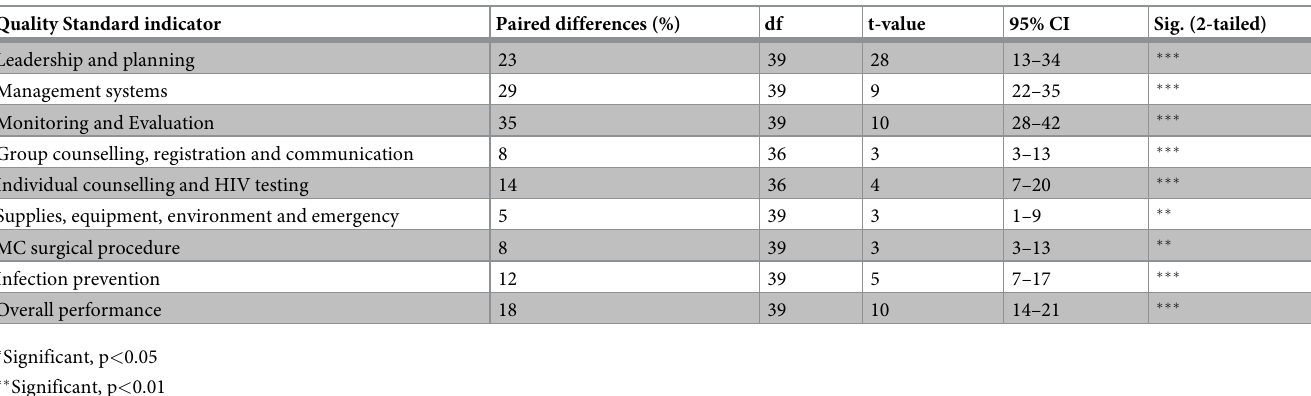
Table 2. Paired samples t-test for overall changes in quality of service mean scores after CQI support intervention by quality standard across provinces. Quality Standard indicator Paired differences (%) df t-value 95% CI Sig.